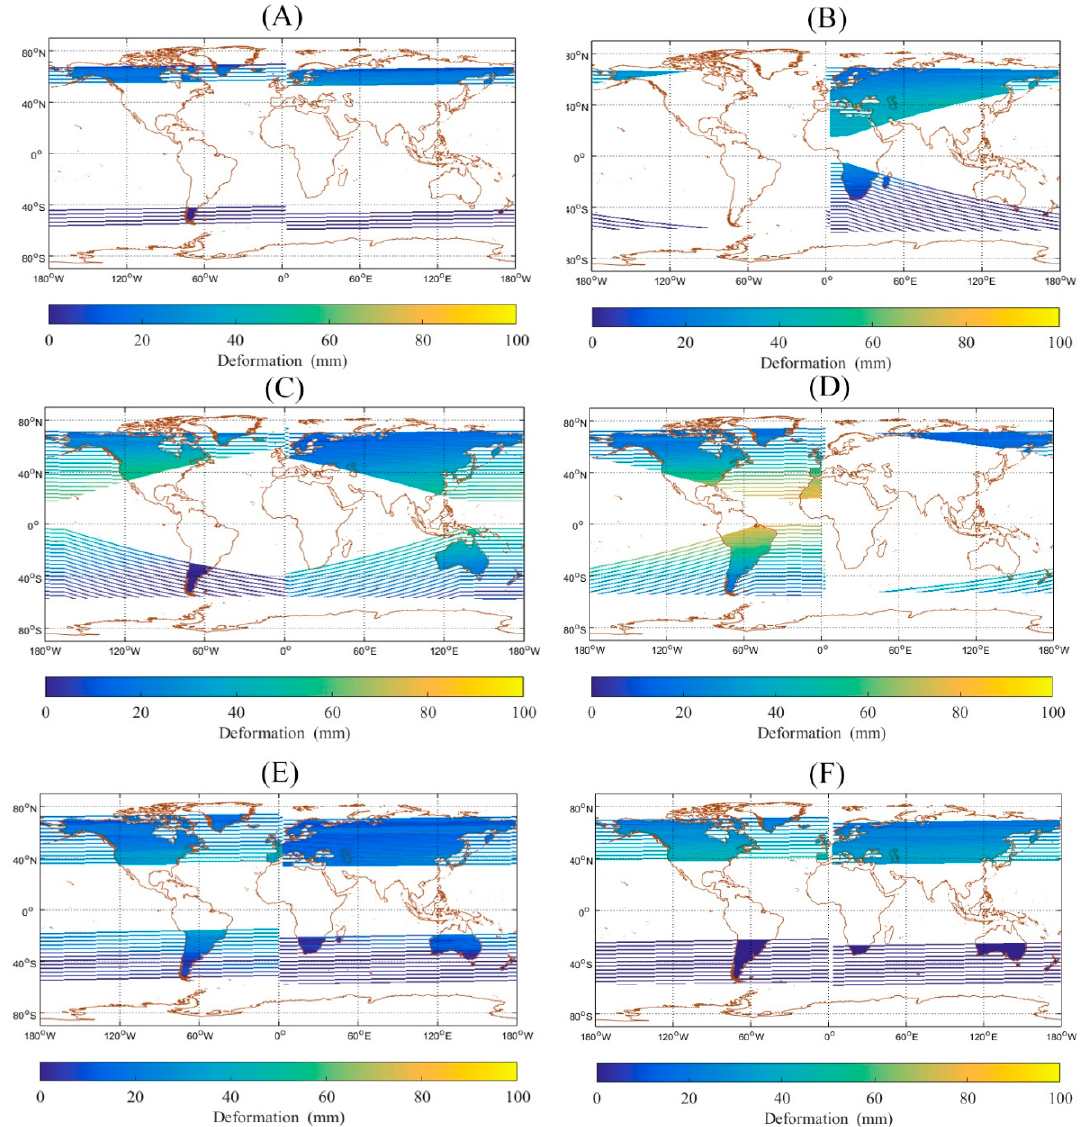
Figure 12. SET deformation distribution of all effective interference combinations (EICs) in the first change period of vertical baseline. ( A – F ) represent the 1st, 16th, 17th, 18th, 25th, and 26th revisits, respectively. The stripe like area represents the effective interference area of lunar SAR, and the deformation value of the terrestrial part is distinguished by different colors.